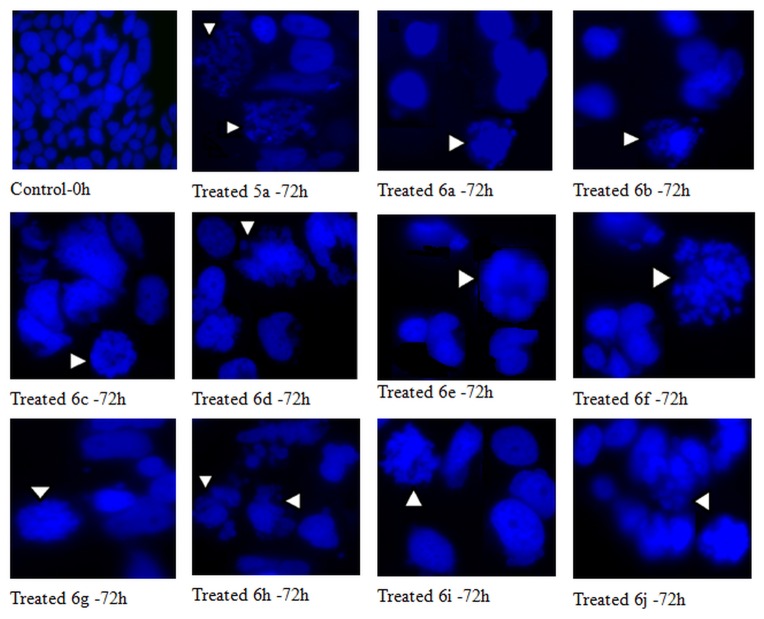
Morphologic indicators of apoptotic cell death include chromatin condensation along the nuclear envelope and plasma membrane blebbing followed by formation small apoptotic bodies.Panels show morphological evaluation of nuclei stained with DAPI in the absence and presence of the analogues 5a and 6a-j (25 µM each). Several typical features of apoptotic cells such as condensed chromosomes, numerous fragmented micronuclei, and apoptotic bodies are evident (indicated by white head arrows) upon 72 hours of drug treatment. (Scale bar = 15 µm).